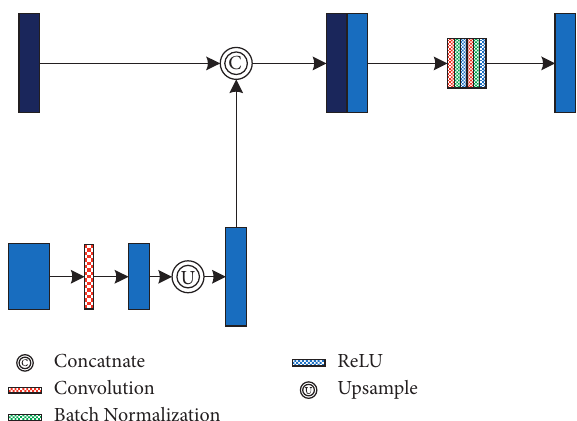
Figure 4: Cross-layer feature block fusion unit, which continually fuses adjacent level feature